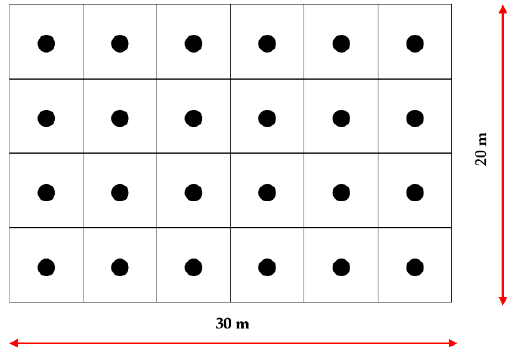
Figure 2. Scheme of the distribution of Dermacentor reticulatus ticks in the field, • —sites of placing the ticks in the experimental plot.